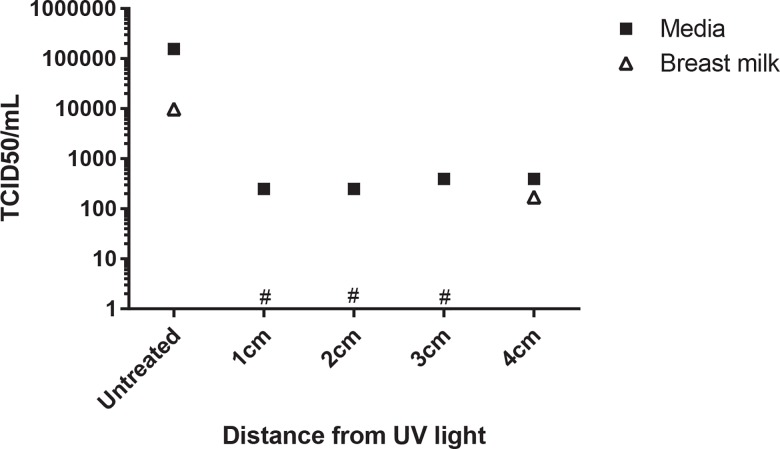
UV exposed AD169 spiked milk and media.Pasteurized breast milk or MEM culture medium were spiked with AD169 culture 1:5. 150 μL samples were irradiated for 10 seconds at 1, 2, 3 or 4 cm from the UV light source (estimated UV intensity 400, 100, 25 and 4 W/cm2 respectively). The irradiated samples were inoculated on to human foreskin fibroblasts (HFF). The presence or absence of CPE was determined for each well and calculated using the Reed and Muench Calculator. Results are presented as TCID50/mL. Breast milk samples with values below the limit of detection are designated (*).